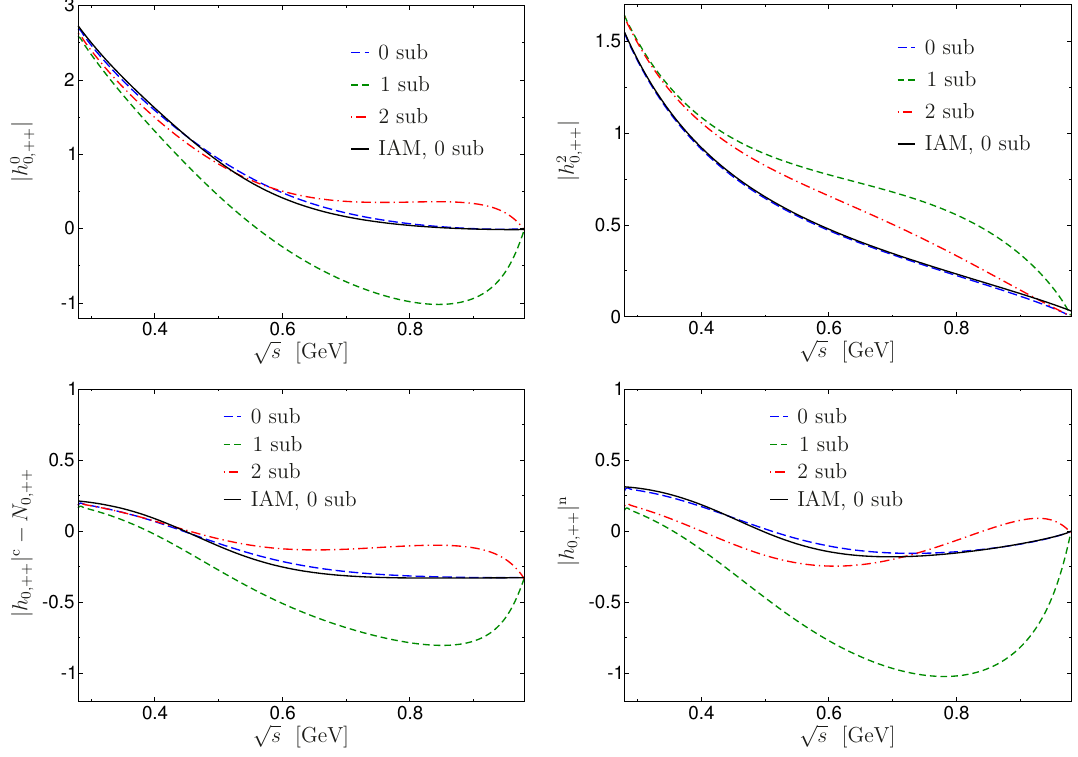
Figure 14. Comparison of the (cid:13)(cid:13) (cid:25)(cid:25) S -waves from this work (black solid line) to the di(cid:11)erent ! subtraction schemes from [55] as indicated. Upper/lower panel: left/right corresponds to I = 0 = 2 and charged/neutral channel, respectively, as explained in the main